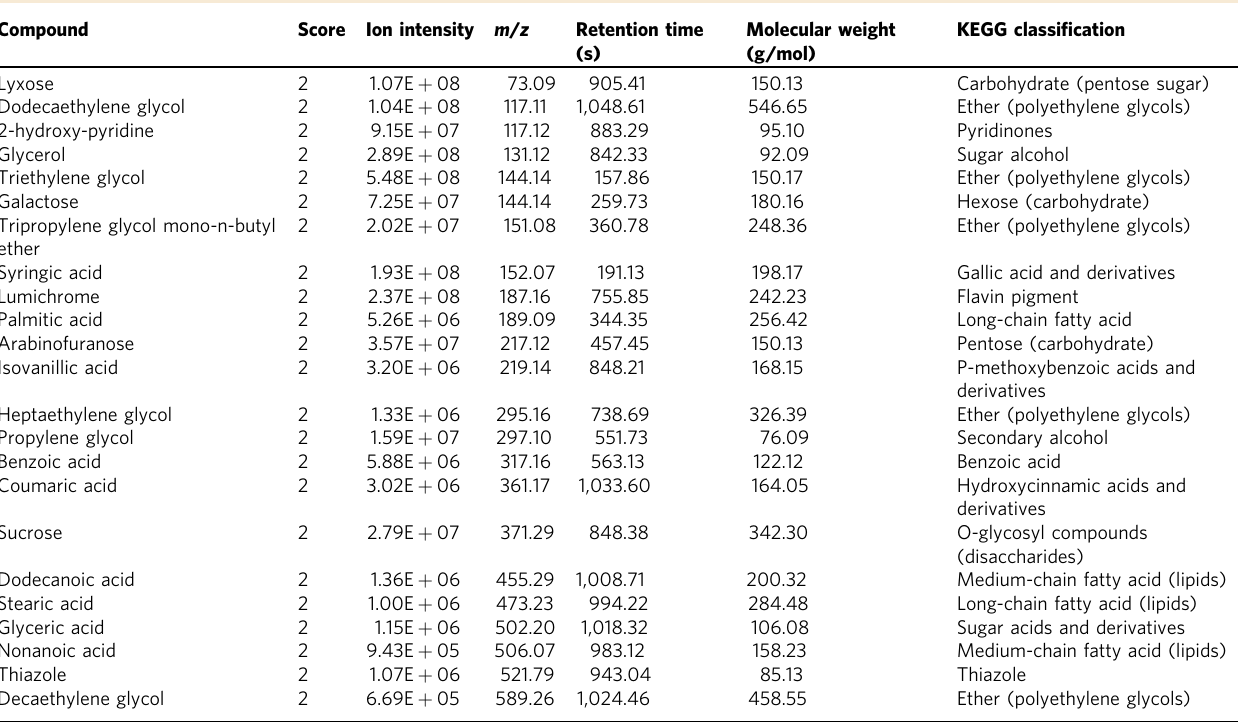
Table 3 Annotated metabolites collected from subalpine watersheds